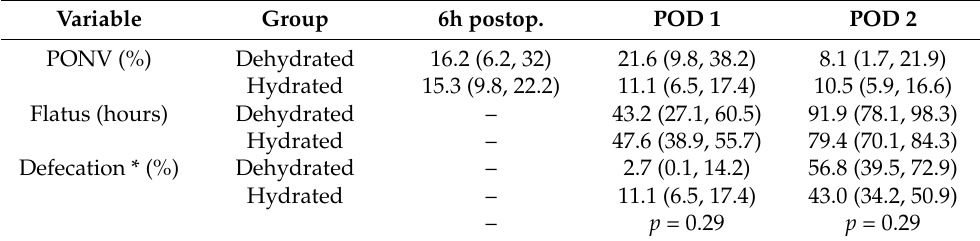
Table 4. Longitudinal secondary outcomes at 6 h postoperatively on POD 1 and